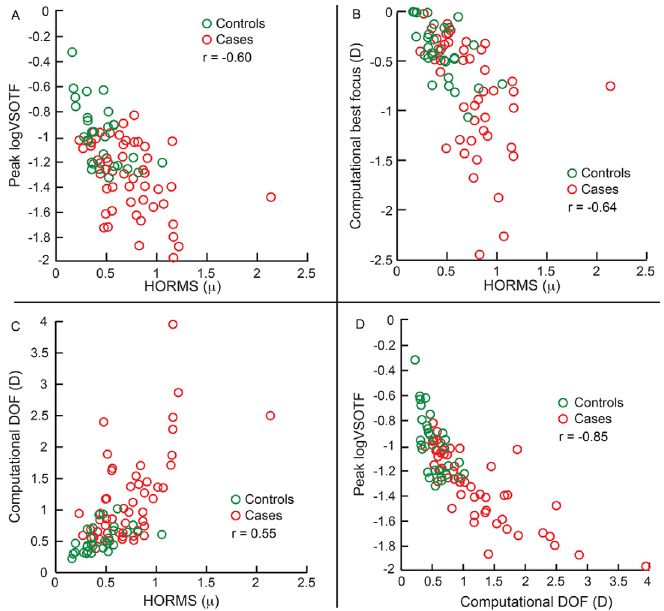
Fig 3. Relation between peak logVSOTF, computational best focus, computational DOF and HORMS obtained from the first arm of the study. Panels A to C show data of peak logVSOTF, computational best focus and the computational DOF of both controls and cases plotted against their HORMS values, respectively. Panel D shows data of peak logVSOTF values plotted against the respective computational DOF.